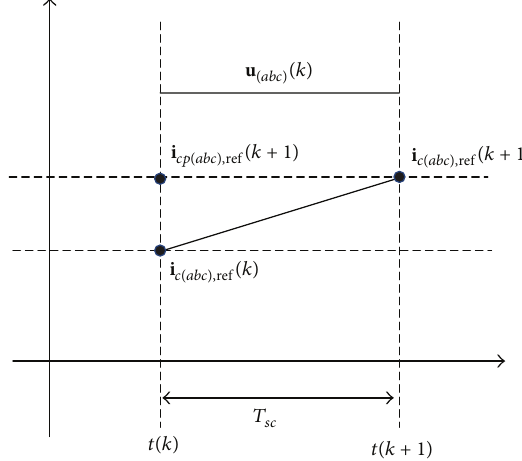
Figure 11: The concept of predictive current control.